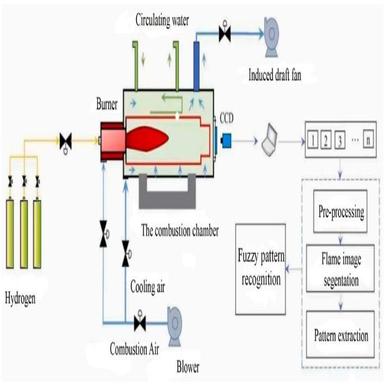
Gas combustion and image detection system structure.